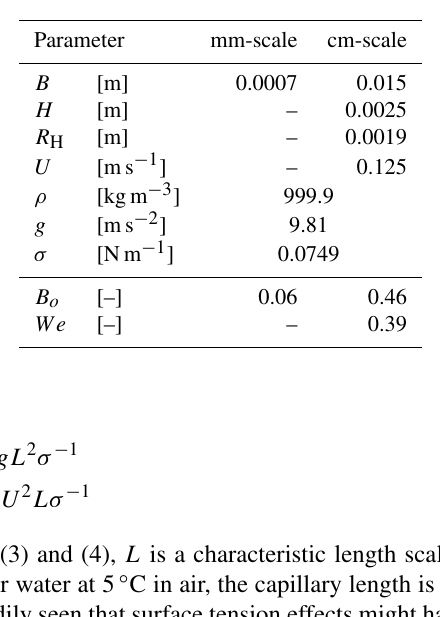
Table 3. Bond and Weber numbers for the laboratory meandering